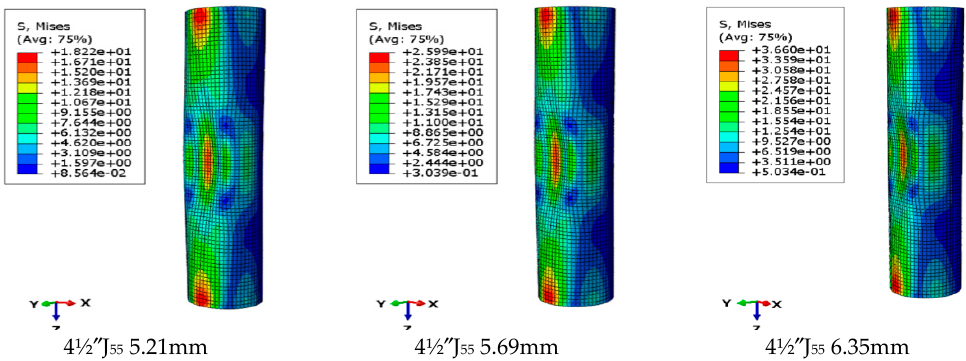
Figure 12. Calculation results of deformation on different wall thicknesses of 4½ ″ J 55 -type casing.